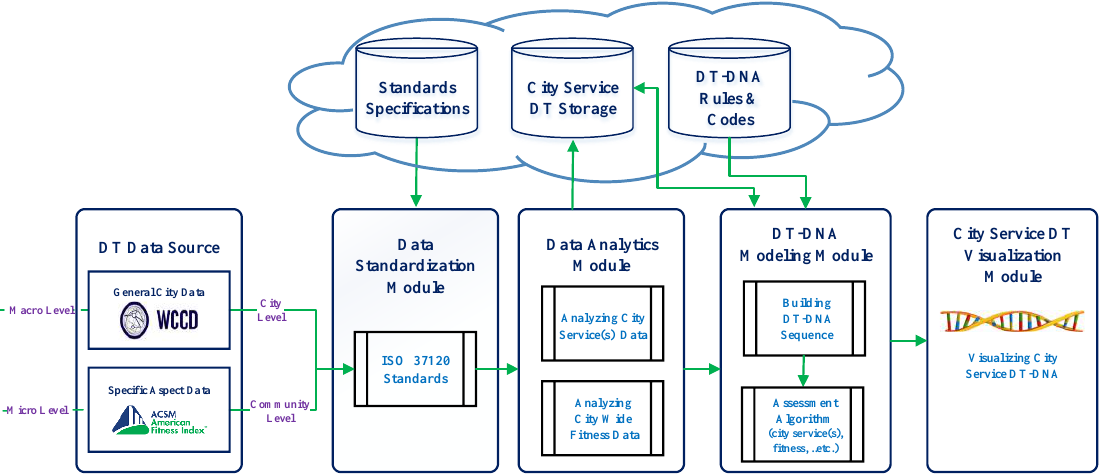
Figure 2. The proposed framework to build digital twins (DTs) of city services.